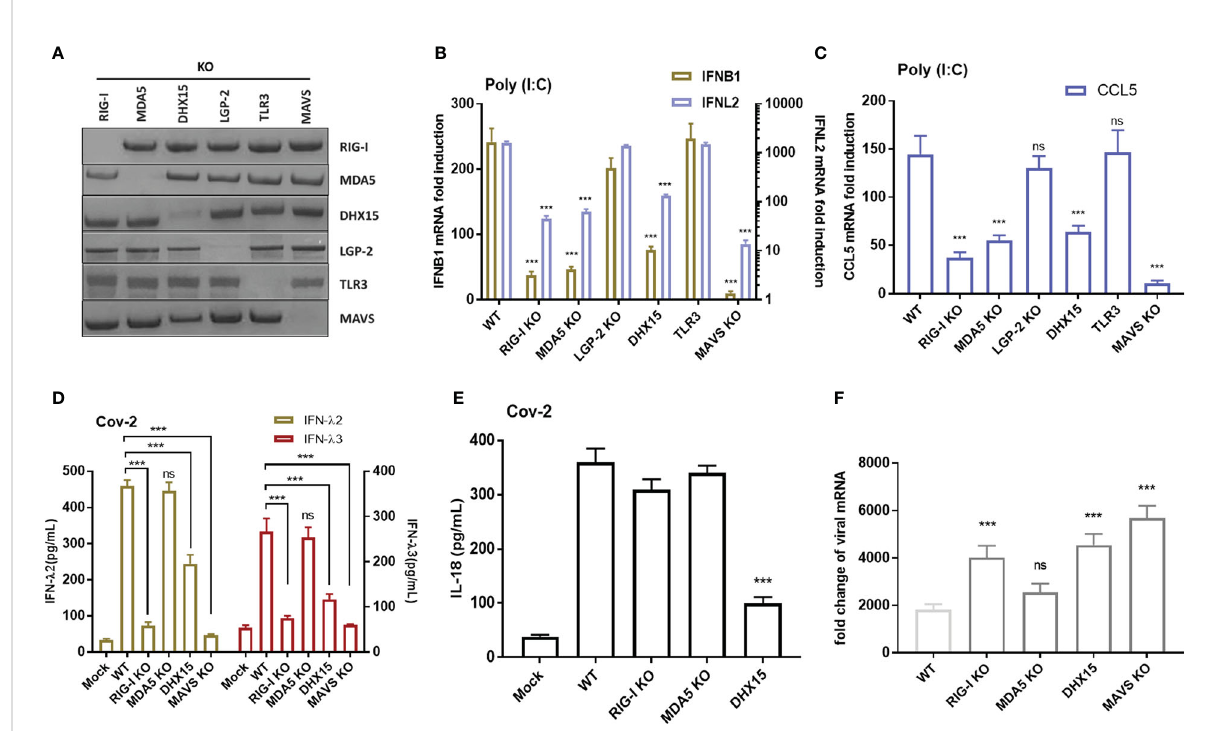
FIGURE 4 RIG-I and DHX15 are required for cellular immune response in IECs upon SARS-CoV-2 infection. (A) Western blot showing the knockout ef fi ciency of multiple RNA sensors with CRISPR-Cas9 system in Caco-2-ACE2-N cells. The right indicated targeted immunoblot proteins. The top showed targeted knockout. (B, C) Cellular immune response to dsRNA analog poly I:C in RNA sensor knockout Caco-2-ACE2-N cells. The knockout cells were transfected with 5 m g/mL poly (I:C) to induce cellular immune response. After 16h post transfection, mRNA expression of IFNB1, IFNL2, CCL5 were quanti fi ed by qRT-PCR. Data are represented with fold changes relative to mock group. (D, E) Cellular immune response to CoV-2 infection in RNA sensor knockout Caco-2-ACE2-N cells . The knockout cells were infected with CoV-2 at 0.5 MOI. At